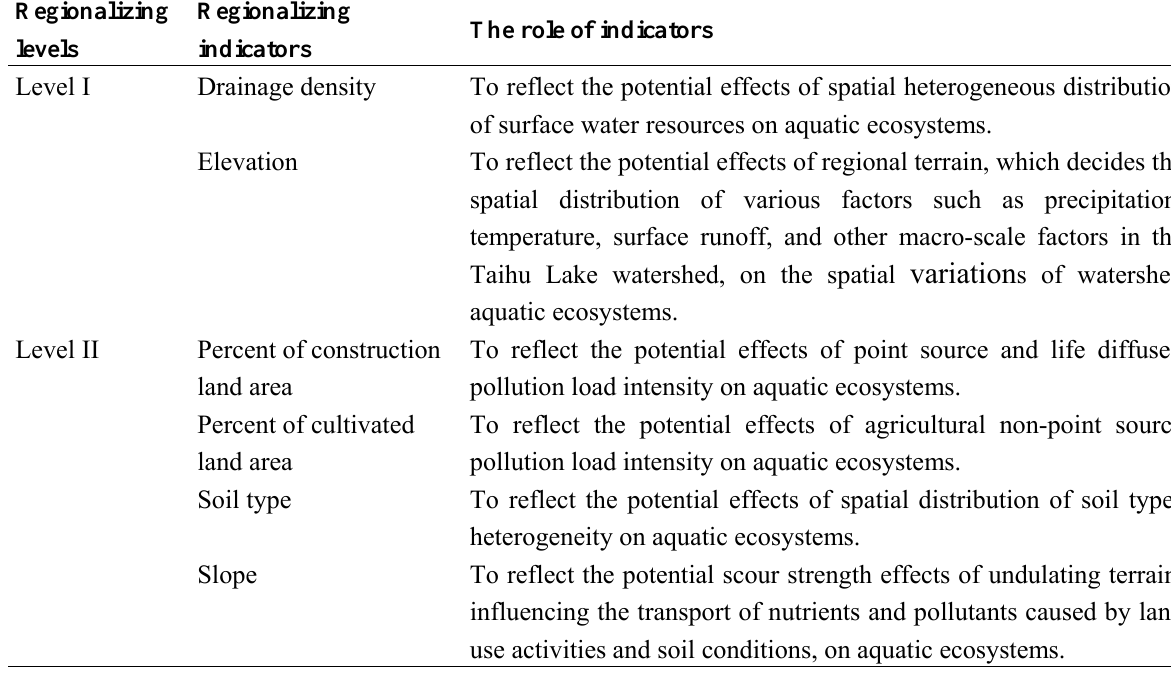
Table 1. Indicators for delineating level I and II aquatic ecoregions in Taihu Lake